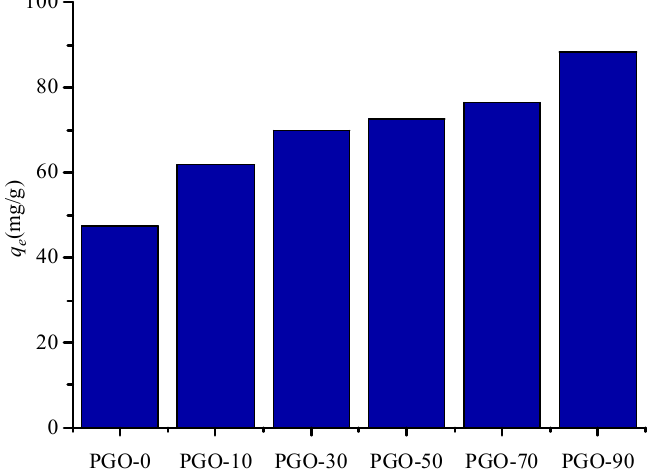
Figure 4. Adsorption capacity of PGO aerogels with different GO contents.